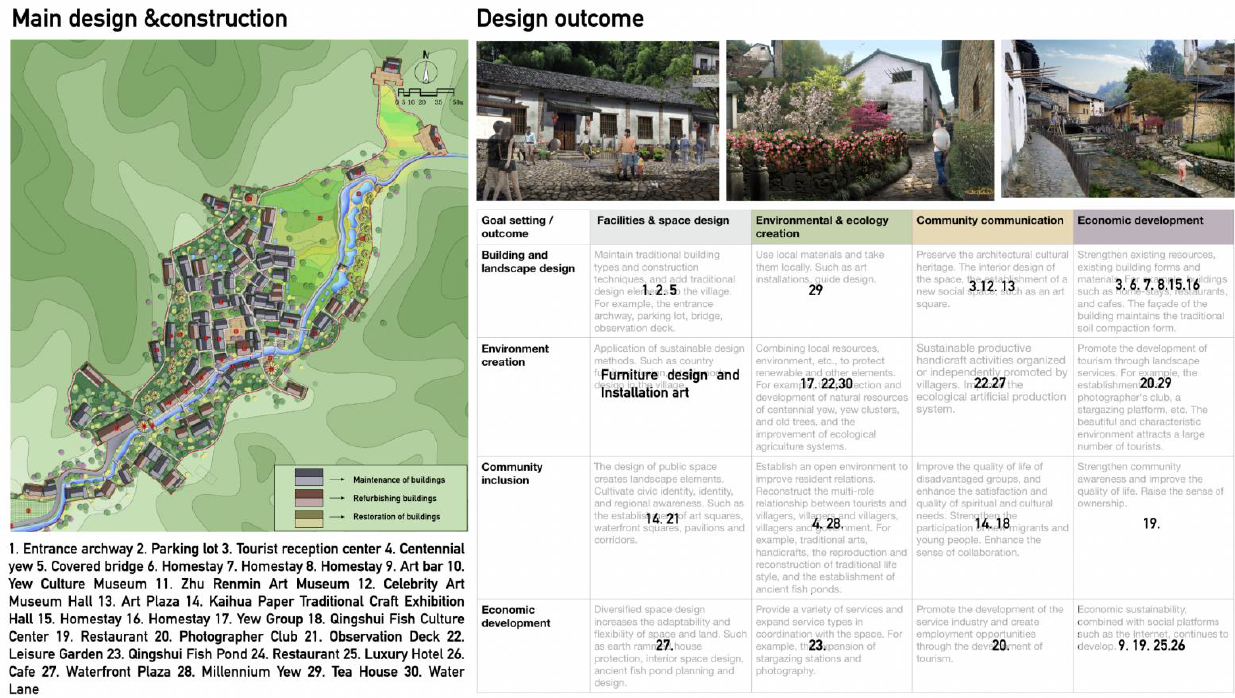
Figure 2. Design and planning of project to renew the Gaotiankeng Village.